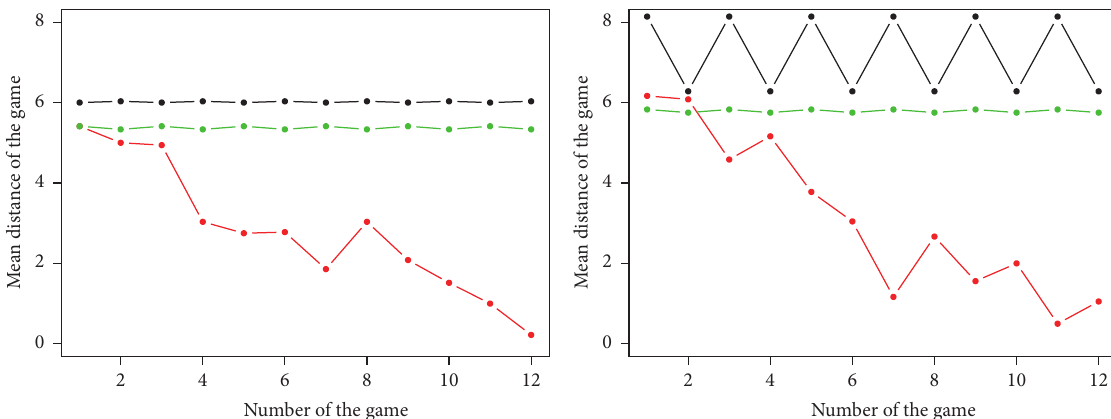
Figure 7: Average distance for each game. Each figure represents a different run of the experiment. The green line represents an AI with no machine learning and which used a uniformly distributed transition matrix. The black line represents the same AI but this time one that used a transition matrix built using game experience, as Hladky and Bulitko did. Finally, the red line was obtained by playing against our AI with adaptive